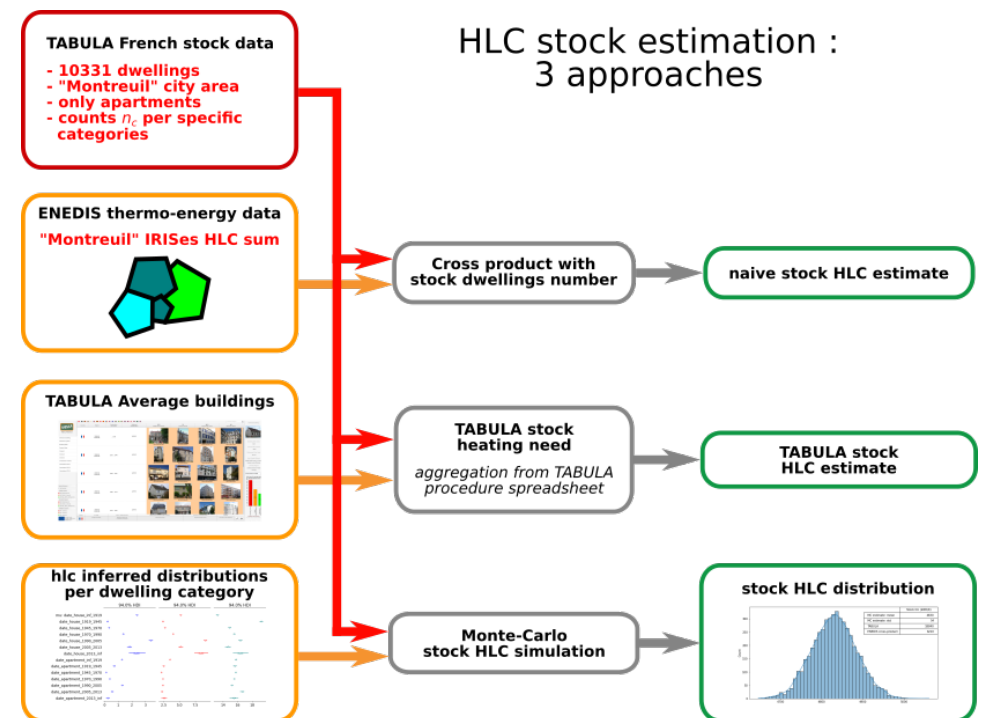
Figure 19. Stock hlc estimation